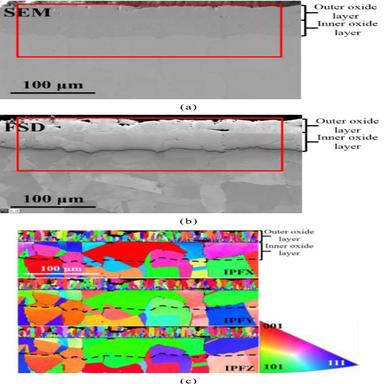
(a) SEM image and (b) FSD image showing a double-layered structure of the surface oxide scale; (c) Inverse Pole Figure (IPF) maps revealing that the outer oxide layer consists of columnar grains and the inner oxide layer remains the same crystallographic orientation with the metal matrix (step size = 0.5 mm).